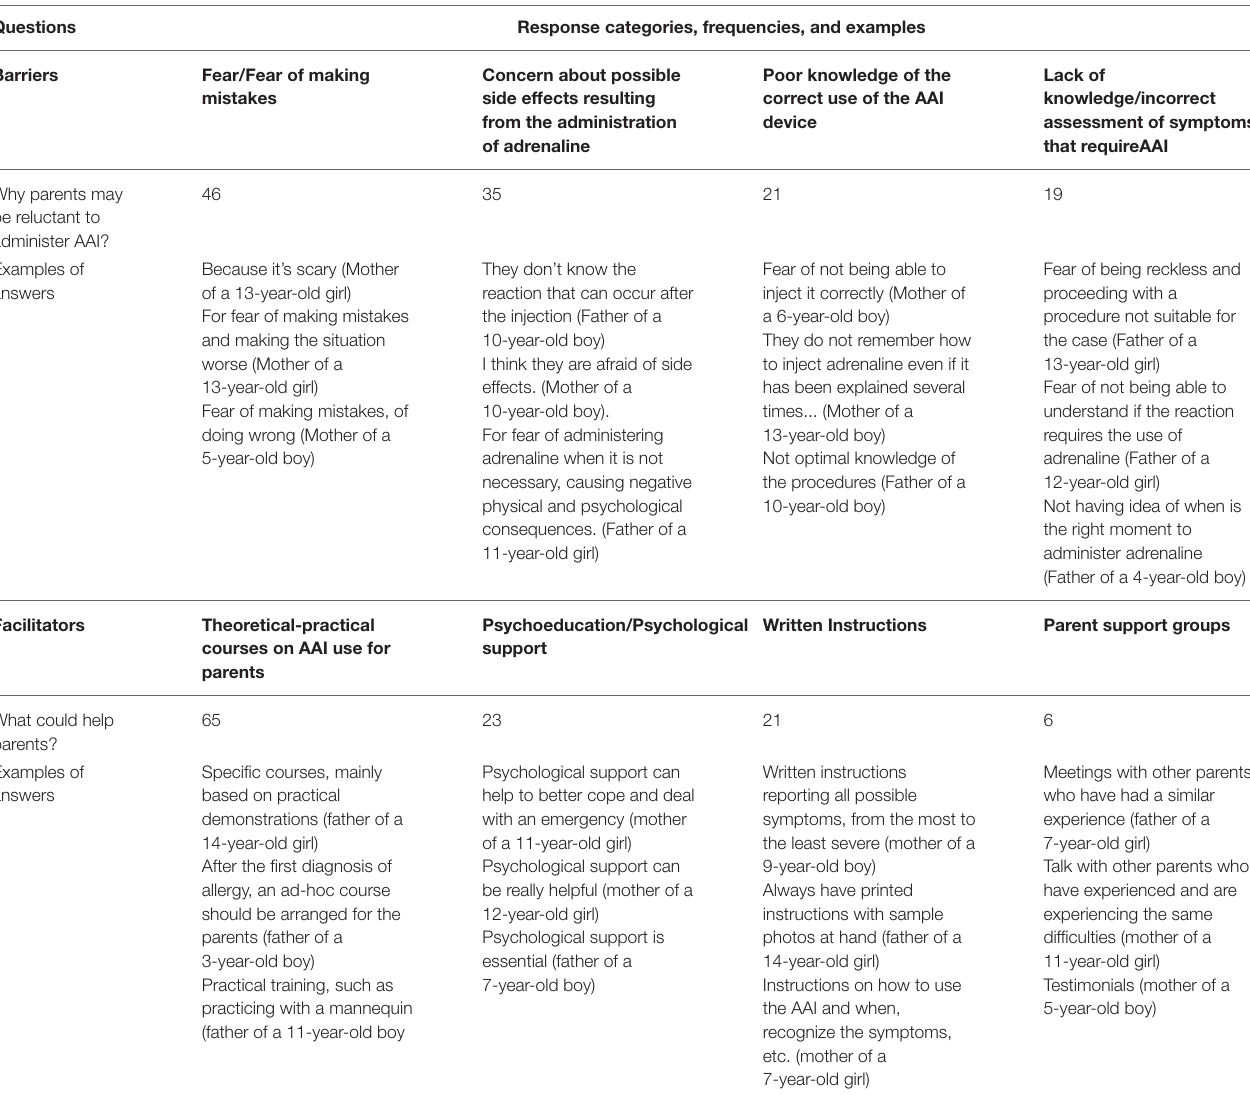
TABLE 3 | Qualitative analysis on parents’ open responses about the barriers and facilitators of using AAI: categories, frequencies, and